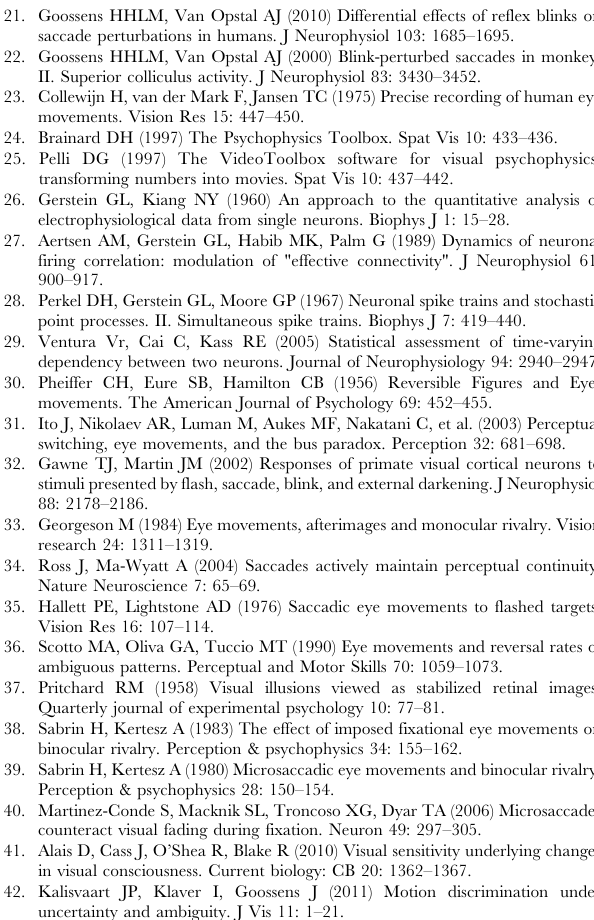
relative to the beep, a stronger effect in the case of beeps would suggest the beeps themselves are important, whereas a weaker effect would suggest it is really the image shift resulting from the saccade (or stimulus jump). To test this, we computed covario- grams of button presses with which subjects indicated percept switches, and auditory cues (beeps). A: switches towards the preferred eye. B: switches towards the non-preferred eye. Top panels show the results from individual subjects. Bottom panels plot the mean 6 SEM across all four subjects (black lines and gray shaded areas). The vertical gray bar is an estimate (mean 6 SD) of the moment that the actual percept switch occurred relative to the moment of the button press. The occurrence frequencies of large saccades have been plotted in the bottom panel for comparison (red). The peaks in beep occurrences were lower and the troughs were not as deep as the ones for saccade occurrences, which means that there was a much larger temporal dispersion of the beeps relative to the percept switches. This indicates that percept switches tended to synchronize with the image shifts themselves rather than with the preceding beeps. (TIF)